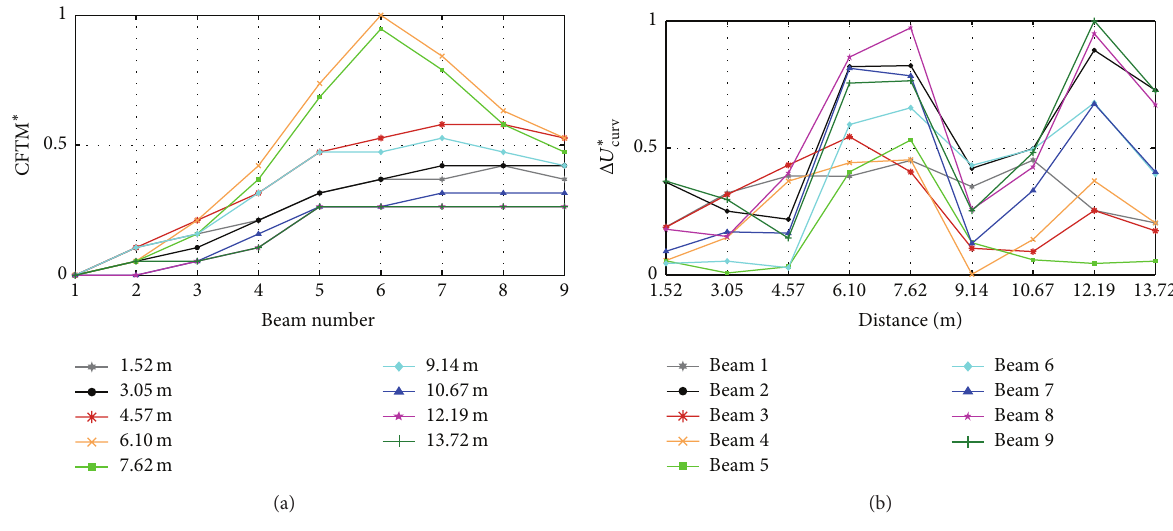
Figure 7: Plot of (a) CFTM ∗ and (b) Δ𝑈 ∗